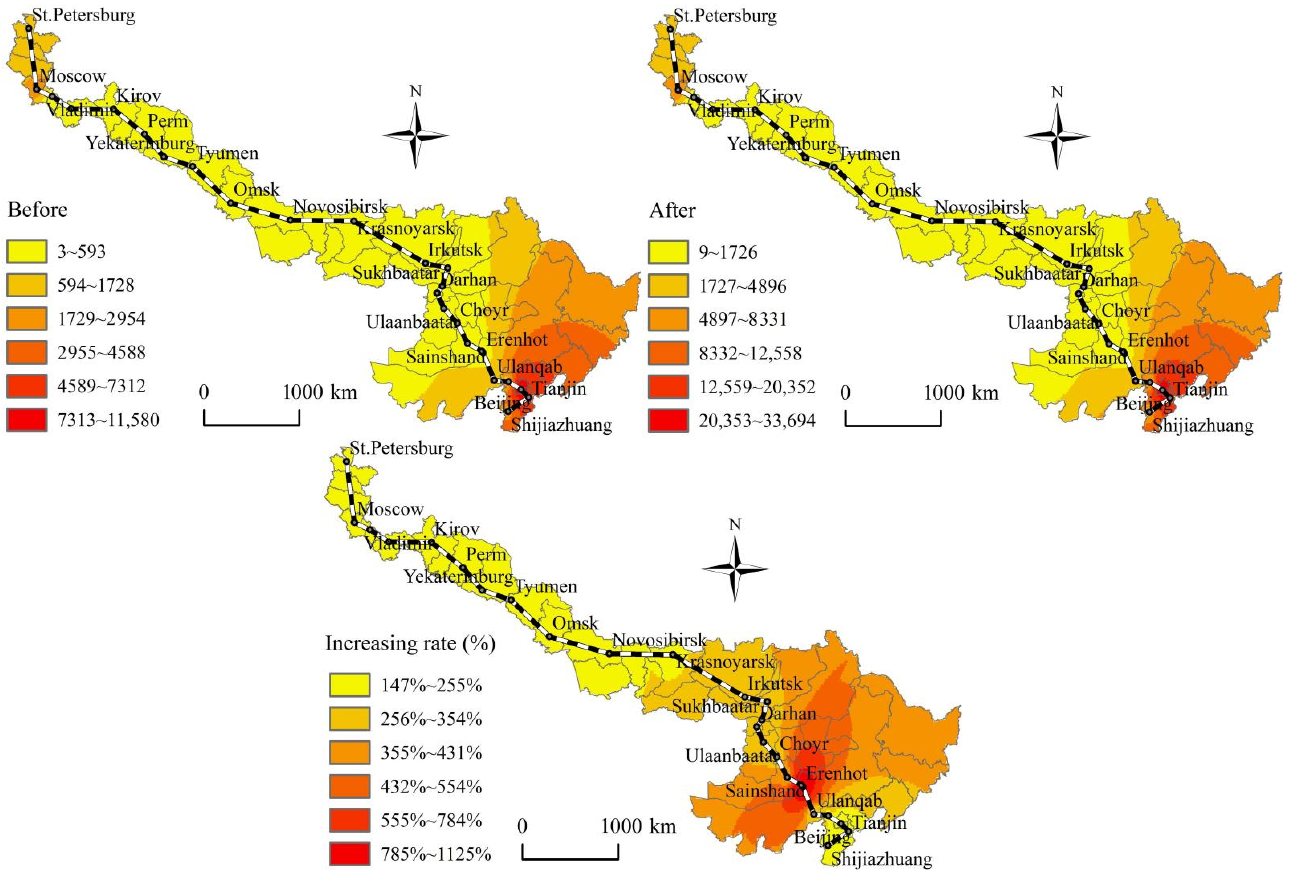
Figure 2. Spatial pattern changes of the weighted average travel time before and after the China- Mongolia-Russia HSR west line opening.